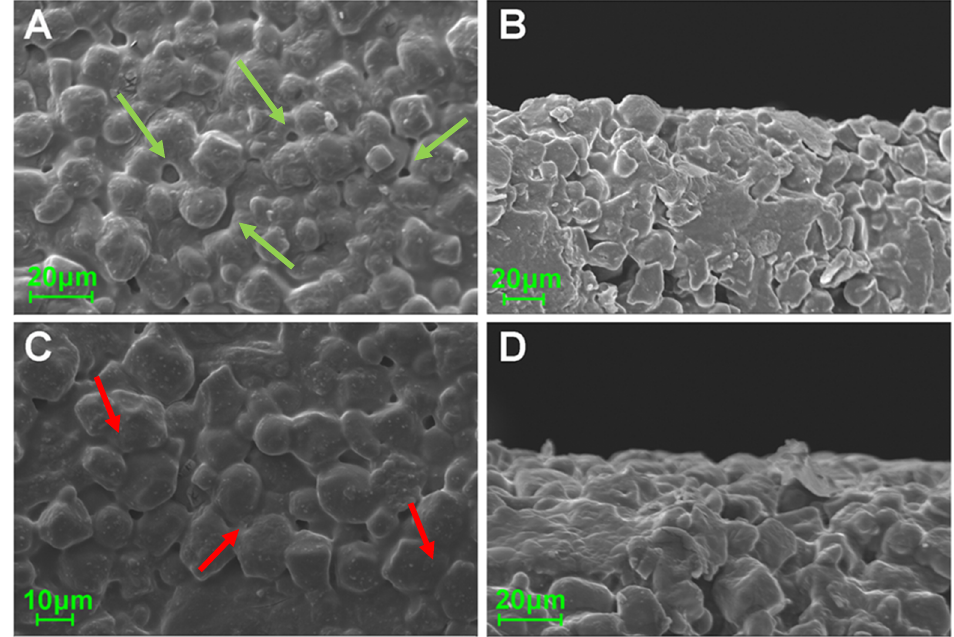
Figure 3. SEM micrographs of the upper and side surfaces of plain ( A , B ) and nine-pass (9)-printed ( C , D ) sugar sheets. The pores are marked with green arrows while the merged grains are marked with red arrows.